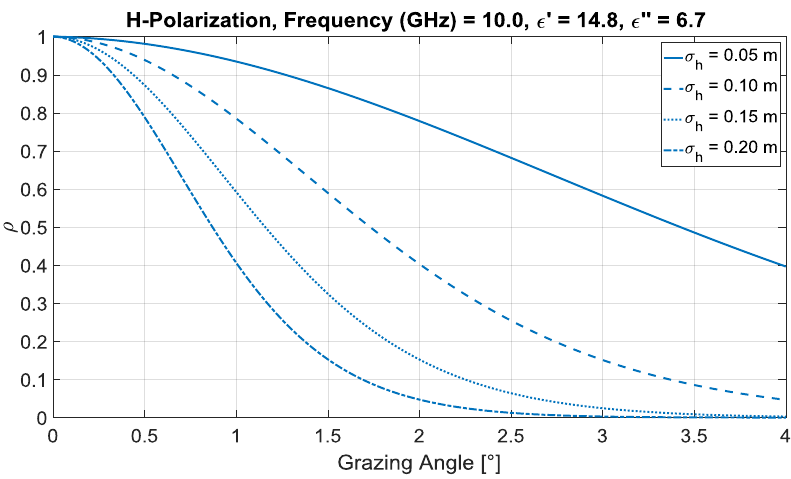
Figure 2. Modulus of the reflection coefficient 𝜌 (X band, horizontal polarization) for soil (clay) with moisture of 35 g/cm 3 , low grazing angles, and four values of 𝜎 ℎ .